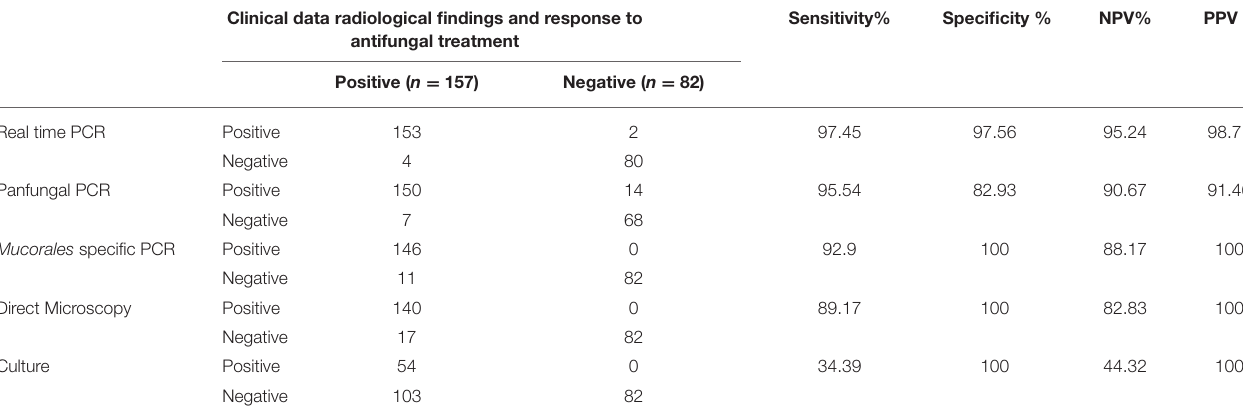
TABLE 4 | Comparison of sensitivity and specificity of qPCR with microscopy, culture, and conventional PCR in IM cases. Clinical data radiological findings and response to antifungal